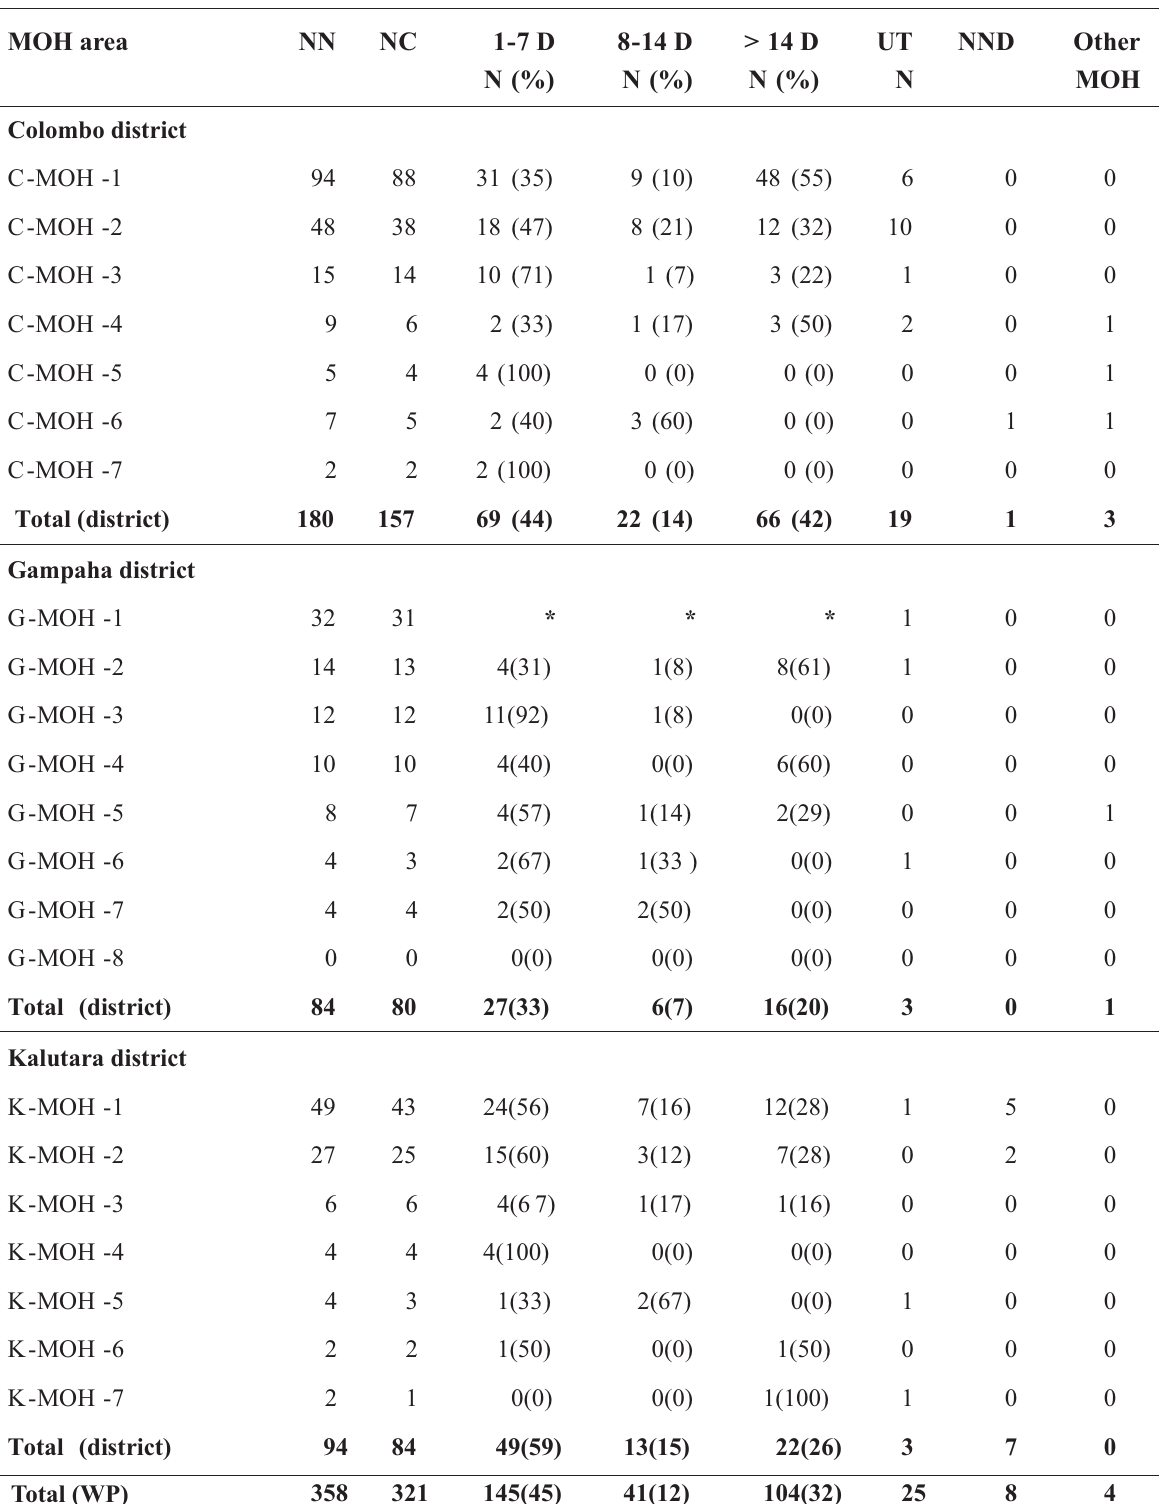
Table 4: Distribution of the status of investigation of notified leprosy cases in selected MOH areas in the Western